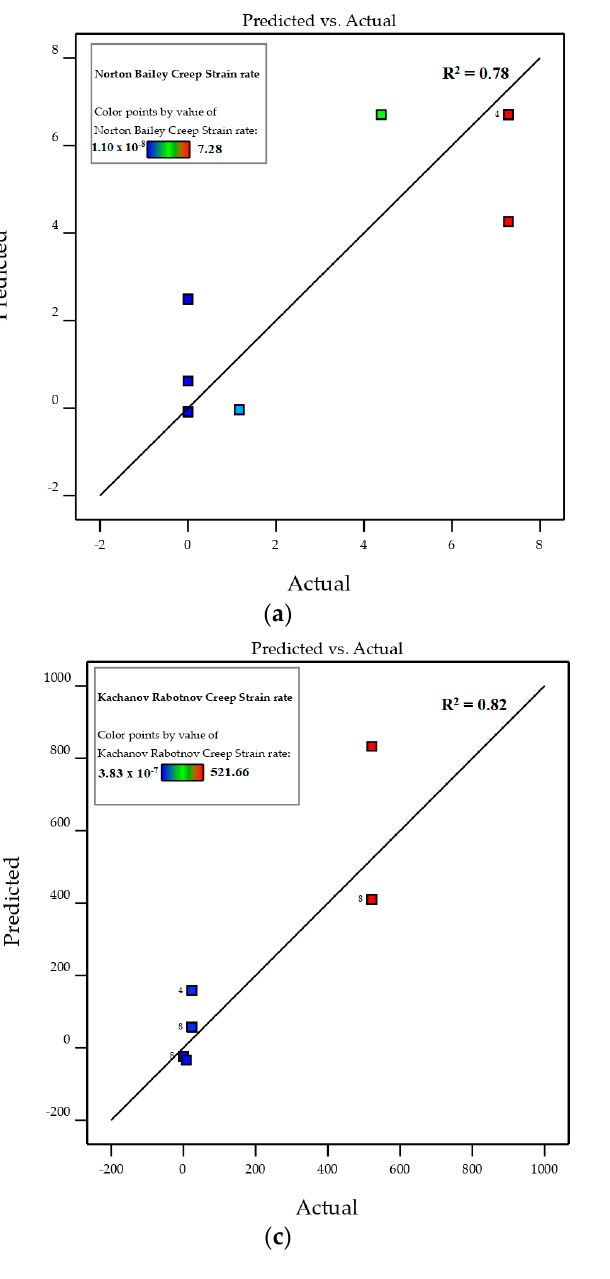
Figure 16. ( a ) Actual vs. predicted values for NB model’s creep strain rate ( ε t ); ( b ) actual vs. predicted values for TP model’s creep strain rate ( ε t ); ( c ) actual vs. predicted values for KR model’s creep strain rate ( ε t ); ( d ) actual vs. predicted values for SH model’s creep strain rate ( ε t